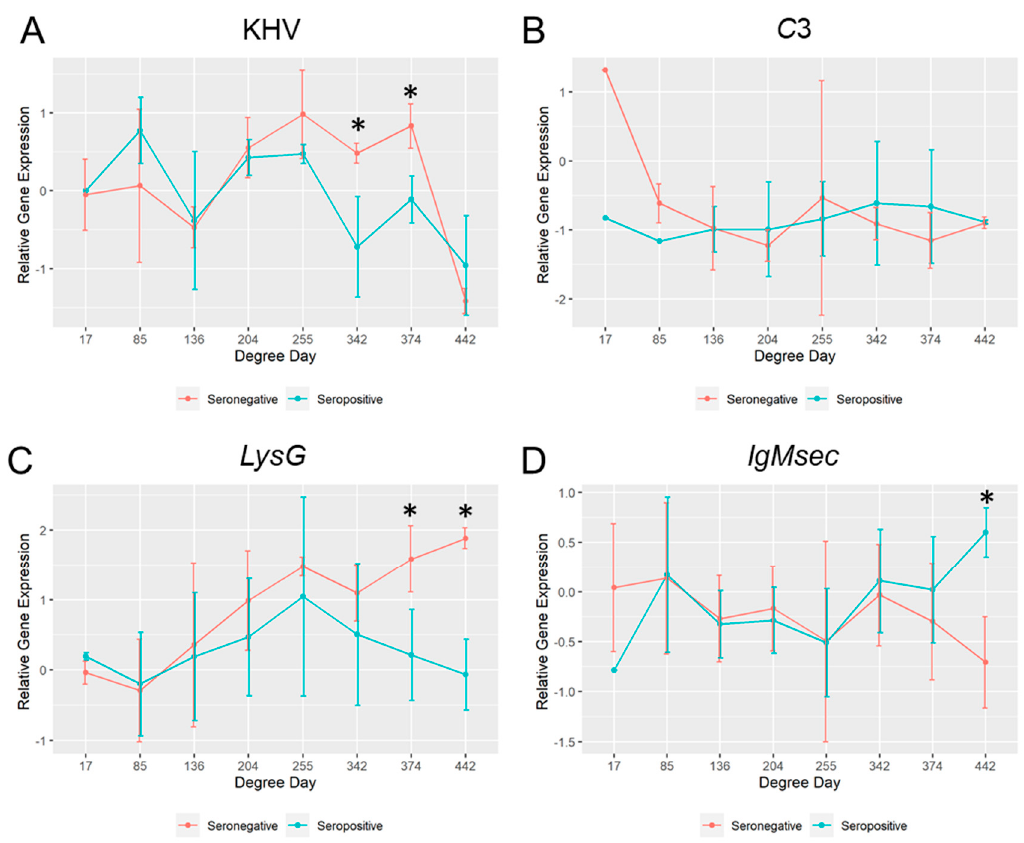
Figure 6. Relative gene expression (fold change) over time in skin swabs from common carp exposed to koi herpesvirus (KHV) held at 17 ◦ C that died before the heat stress (seronegative group) vs. survivors (seropositive). ( A ) KHV orf90 (viral shedding); ( B ); complement c3-h1 ( c3 ); ( C ) Lysozyme g ( lysG ); ( D ) immunoglobulin M heavy chain secretory protein ( IgMsec ). (*) Denotes gene expression significantly di ff erent ( p ≤ 0.05) among